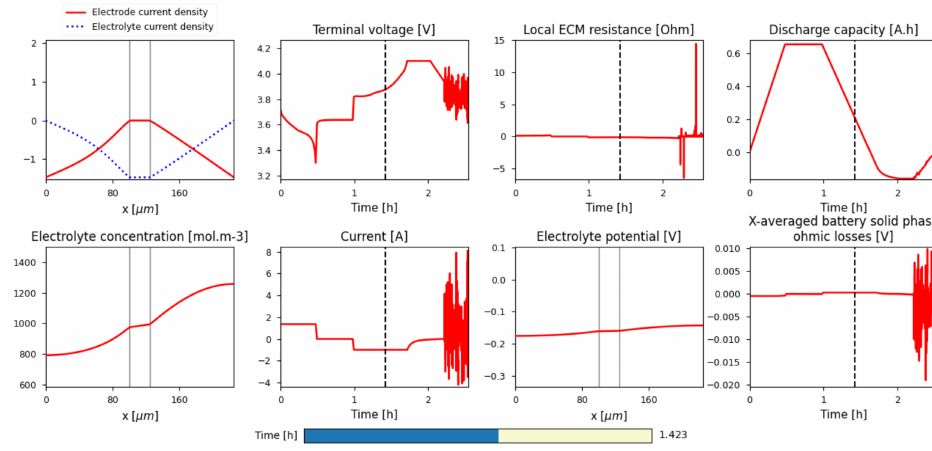
Figure 6. DFN model output variables for discharge based on code